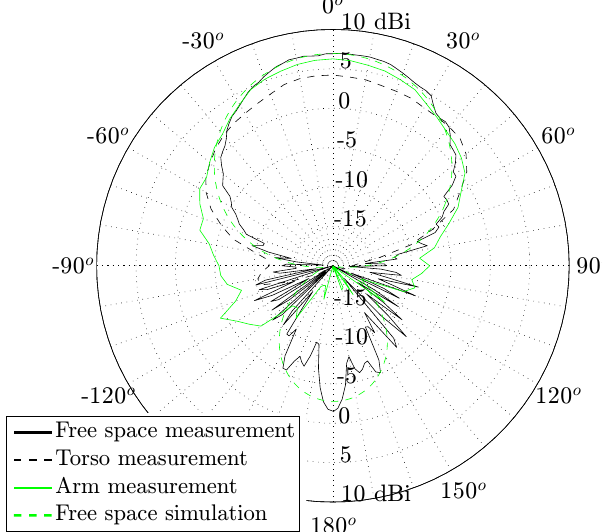
Figure 16. Measured vs. simulated 5.50 GHz H-plane radiation patterns of the U.FL antenna, free space vs. on body.